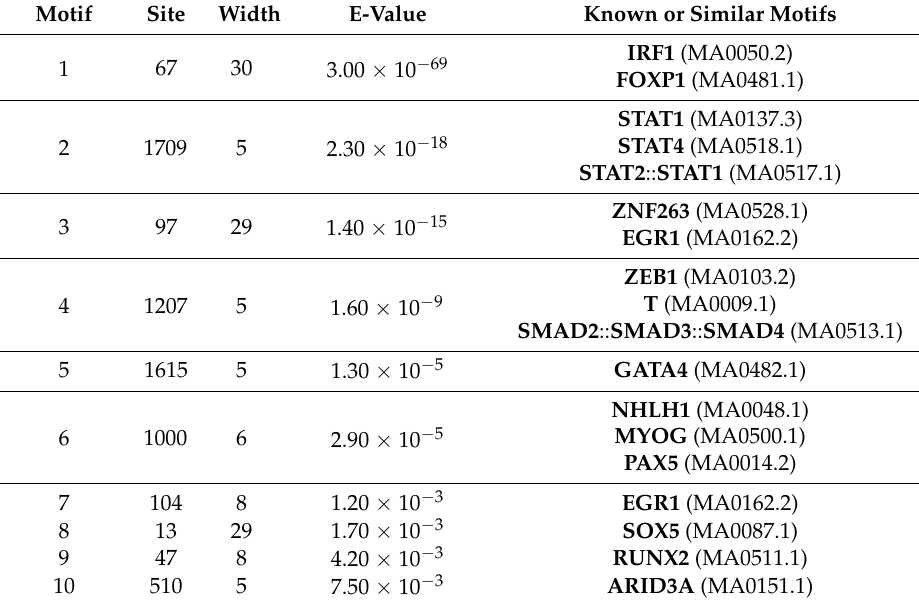
Table 1. Transcription factor (TF)-binding motifs in differentially methylated regions (DMR)-promoter-overlapping regions.